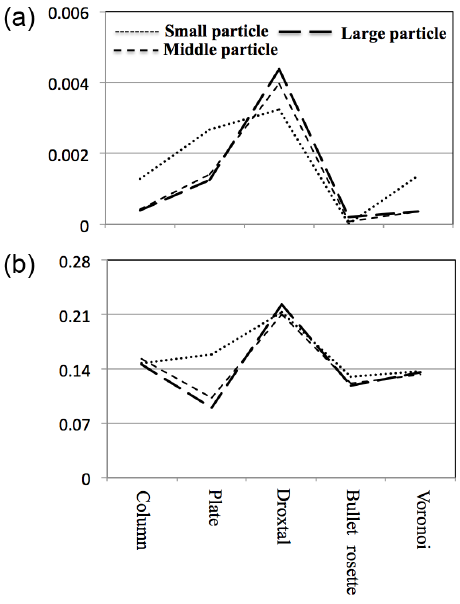
Figure 7. The slope of the regression function and total relative albedo difference in Fig.